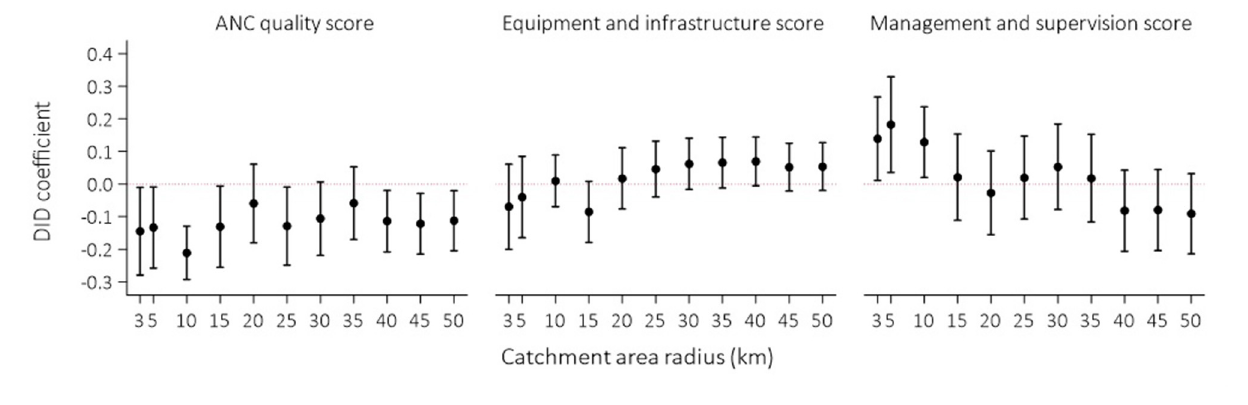
FIGURE 1 | Variation in DID estimates with catchment area